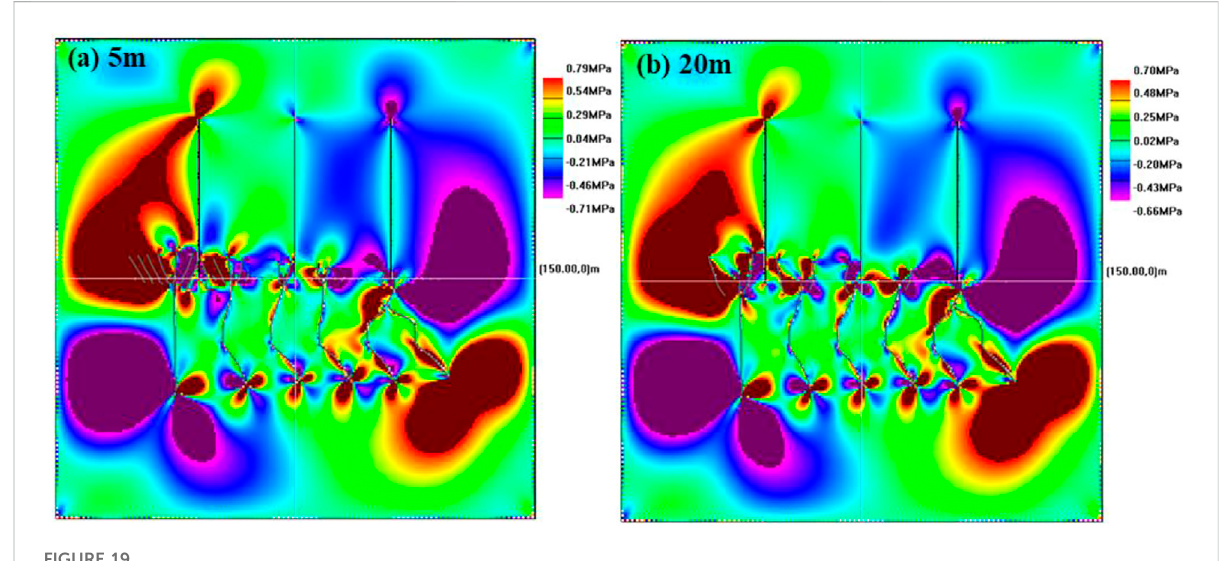
FIGURE 19 Distribution of shear stress under different natural fracture